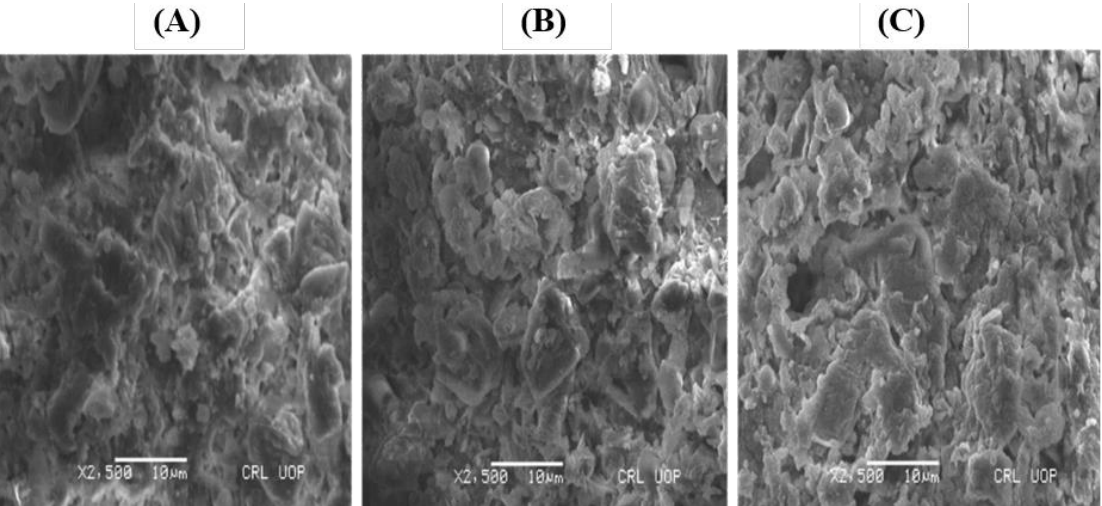
Figure 3. SEM micrographs of Nostoc sp. MK-11 ( A ) raw biomass, ( B ) Cd-loaded biomass, ( C ) Pb-loaded biomass.